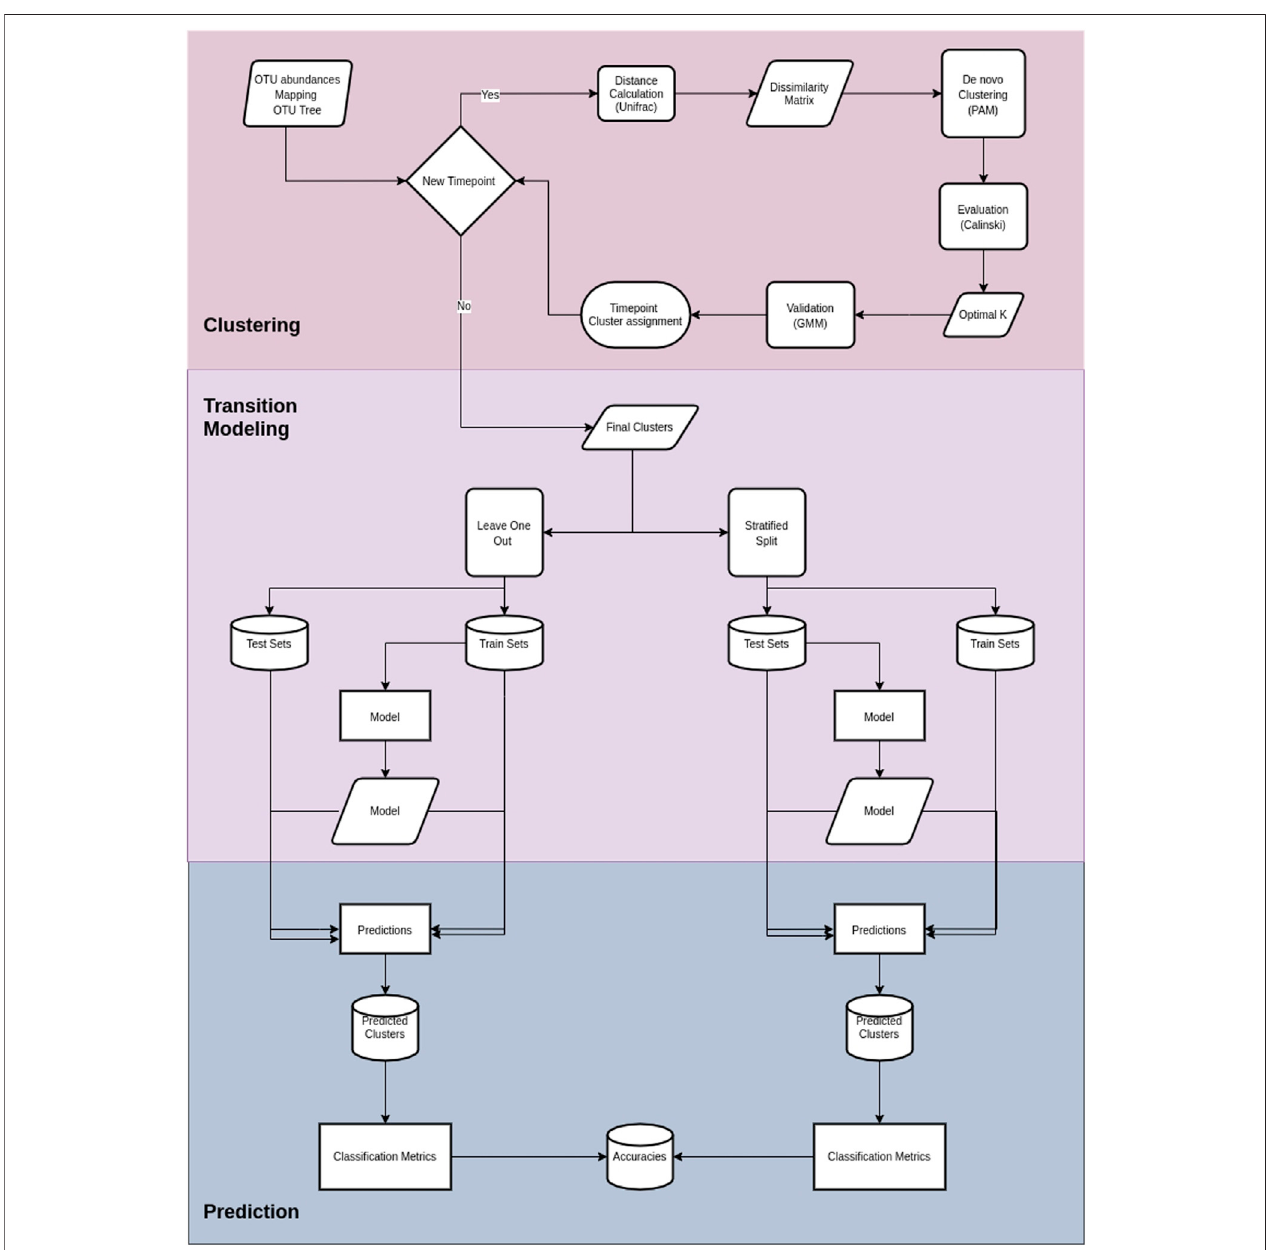
FIGURE2| Cronos ’ pipeline.The fi rstsectionillustratestheproceduresonCronosfromobtainingthedatatoformingcompleteclusteringassignments.Themiddle section demonstratesthemodelingoftransitionsfrom clustersonatimepoint toany later.Thethirdsection displays theprediction procedure andclassi fi cationmetrics.